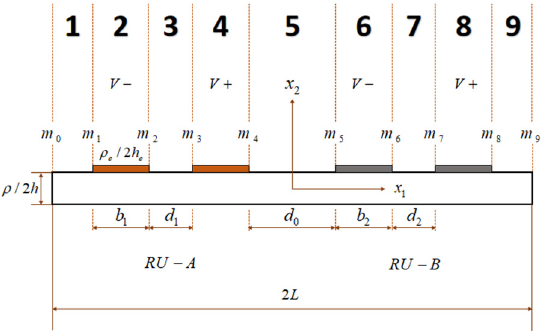
Figure 3. The partition diagram of LiTaO 3 array devices with lateral-field-excitation.